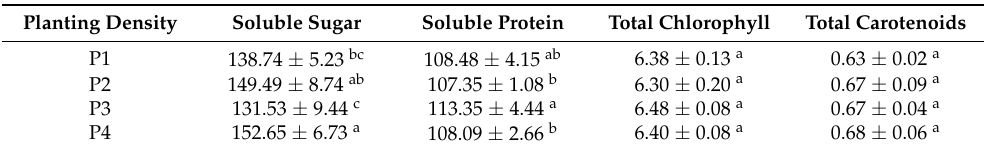
Table 2. Soluble sugar, soluble protein, chlorophyll, and carotenoids content in different planting densities of mustard sprouts (mg g − 1 ).